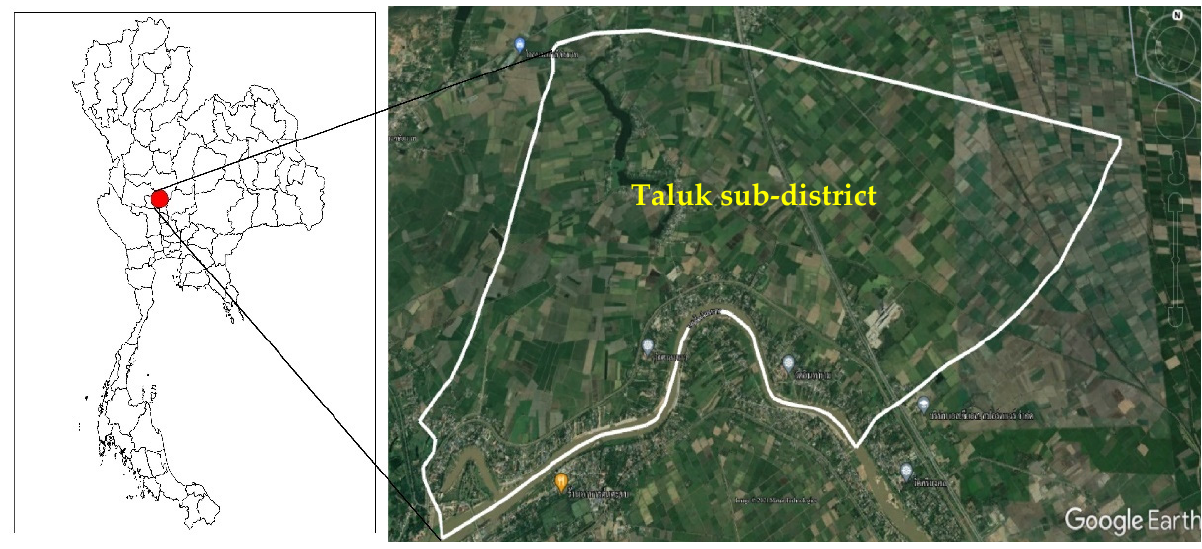
Figure 2. Study area.